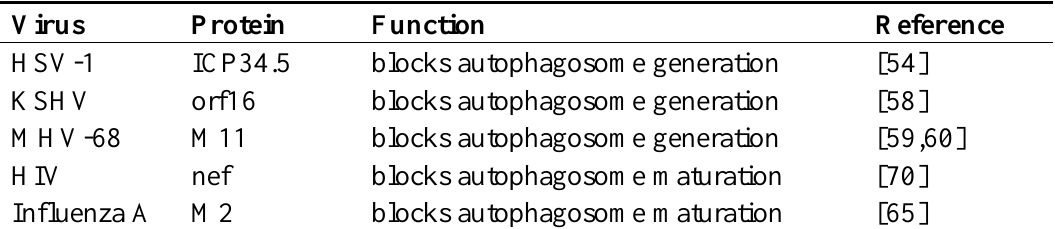
Table 1. Viral proteins that interact with